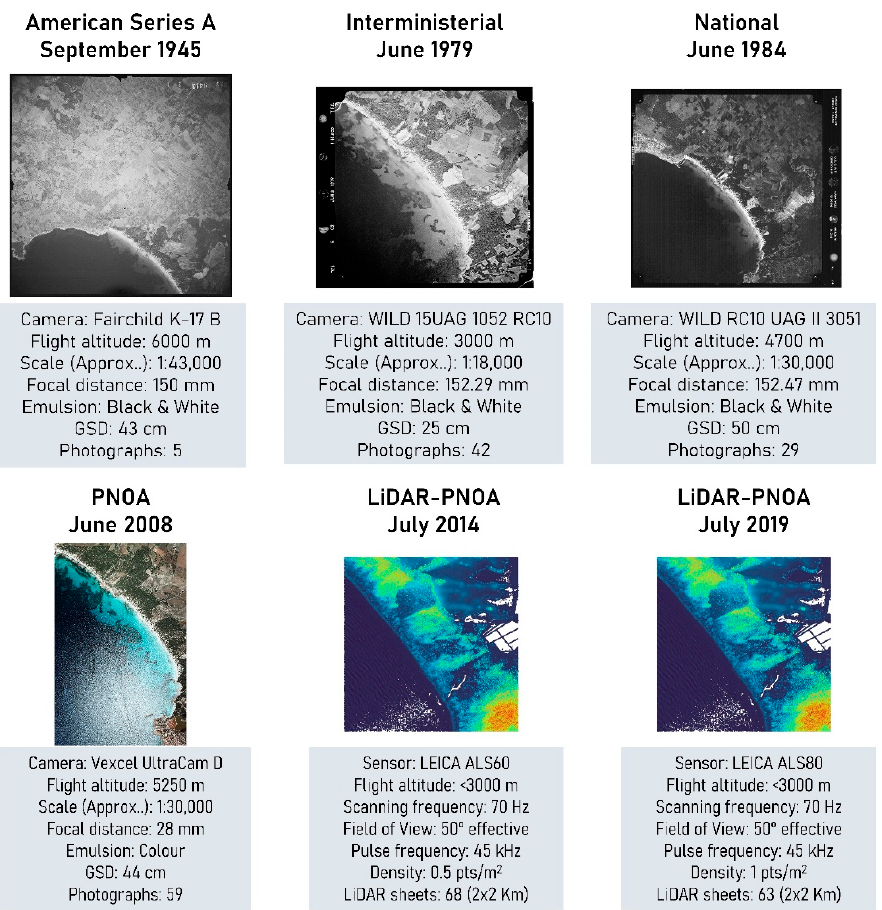
Figure 2. Characteristics of the historical aerial photograph series and LiDAR coverages used in this